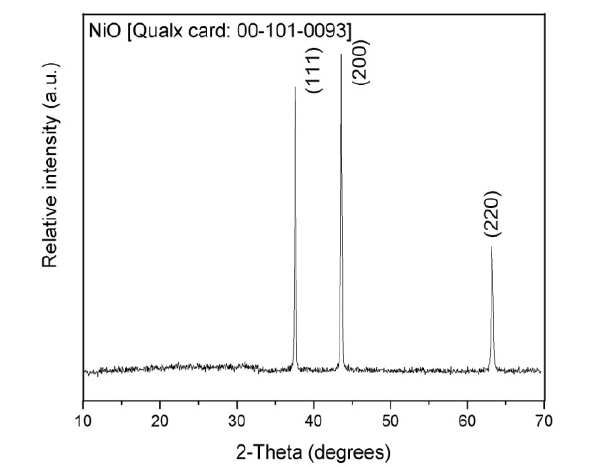
Figure 2 – XRD pattern of the sample prepared without using NaOH Рис . 2 – Дифрактограмма образца , подготовленного без NaOH Слика 2 – Дифрактограм узорка припремљеног без